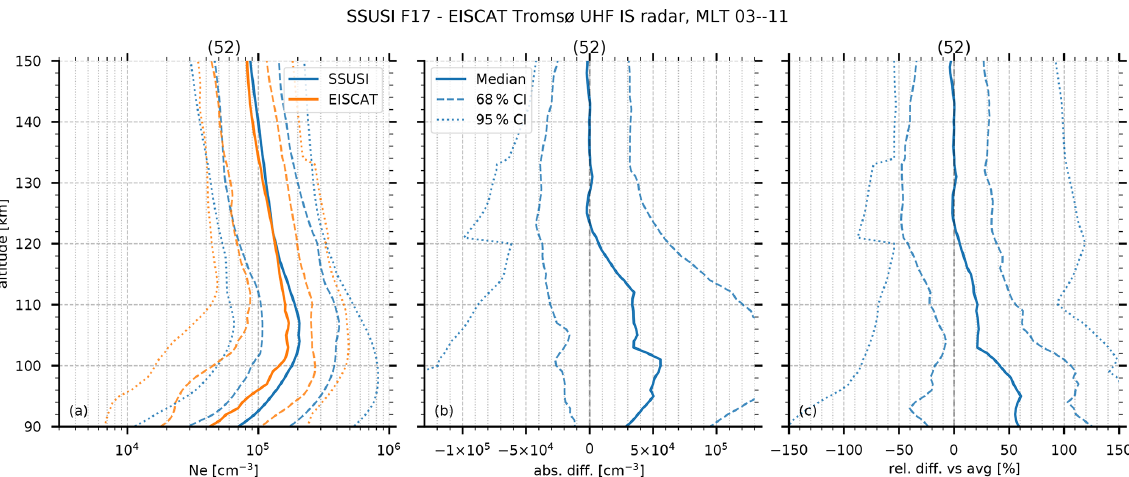
Figure 2. Profile comparison of calculated electron densities from SSUSI on DMSP/F17 to the ones measured by the EISCAT Tromsø UHF radar for early MLT (03:00–11:00MLT). Density profiles (a) , absolute differences (b) , and relative differences (c) . Shown are the medians (solid lines) and the 68% (dashed) and 95% (dotted) confidence intervals for the SSUSI-calculated electron densities (blue) and EISCAT (orange). The numbers in parentheses indicate the number of coincident satellite orbits used for averaging. The SSUSI profiles have been calculated assuming a Maxwellian electron spectrum with E 0 = E SSUSI / 2 and 35eV per ion pair. Note that the density profiles (a) are on a logarithmic